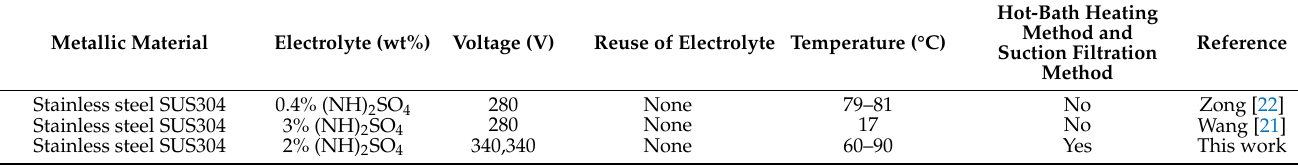
Table 3. Comparison of the plasma electrolytic polishing process parameters.